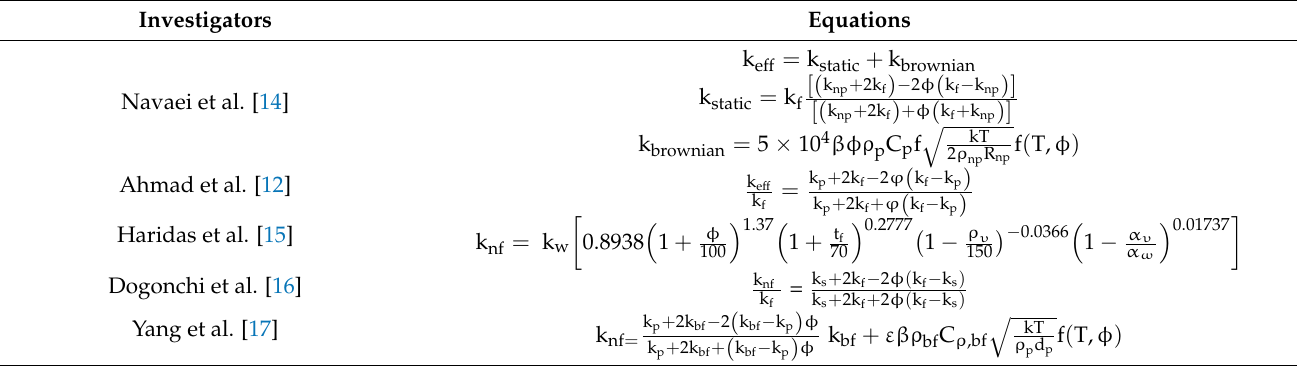
Table 1. Equations used for calculating the thermal conductivity of